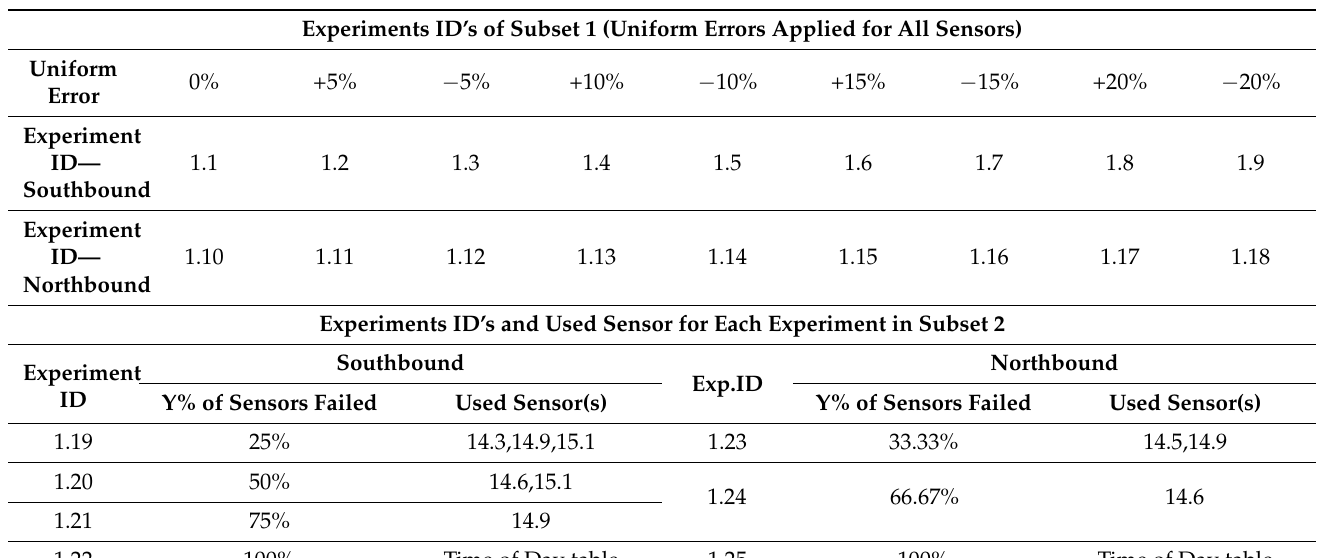
Table 2. Experiments of systematic detection error in Scenario 1.